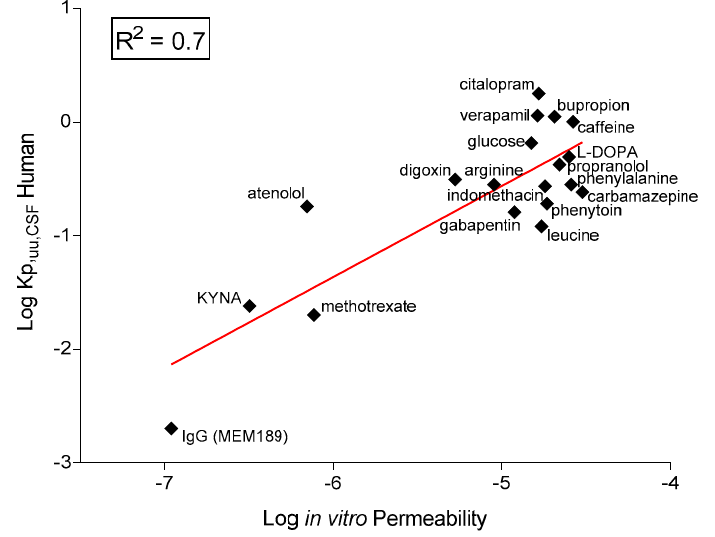
Figure 8. In vitro–in vivo correlation. Correlation between in vitro log permeability from iBMEC- healthy and in vivo human Log K p,uu,CSF (data collected from the literature, Table S4). The solid line is the linear regression with an R 2 value of 0.7.